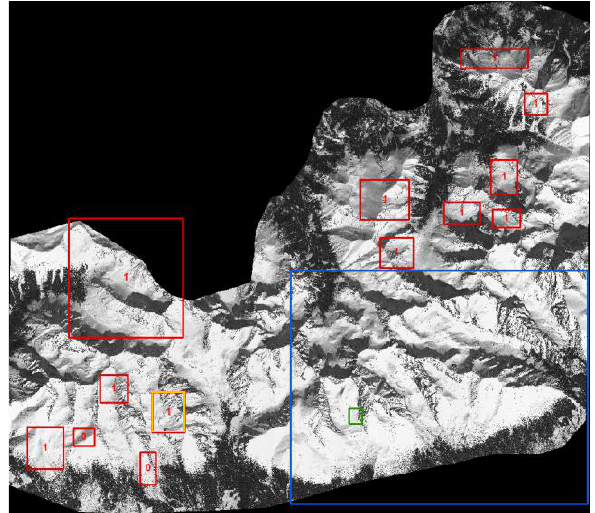
Figure 4: Eastern part of the WorldView-1 imagery from April 2, 2009. Blue rectangle = algorithm training area; green rectangle = location of example shown in Figure 5; red rectangles = randomly selected test areas for validation (0 = no avalanches present; 1= avalanches present); orange rectangle = location of example shown in Figures 7, 8. (Satellite image: Copyright © DigitalGlobe/WorldView-1; courtesy of Slovakian Avalanche Prevention Center).